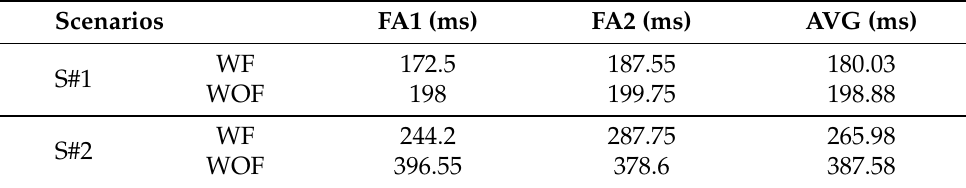
Table 4. Error detection time